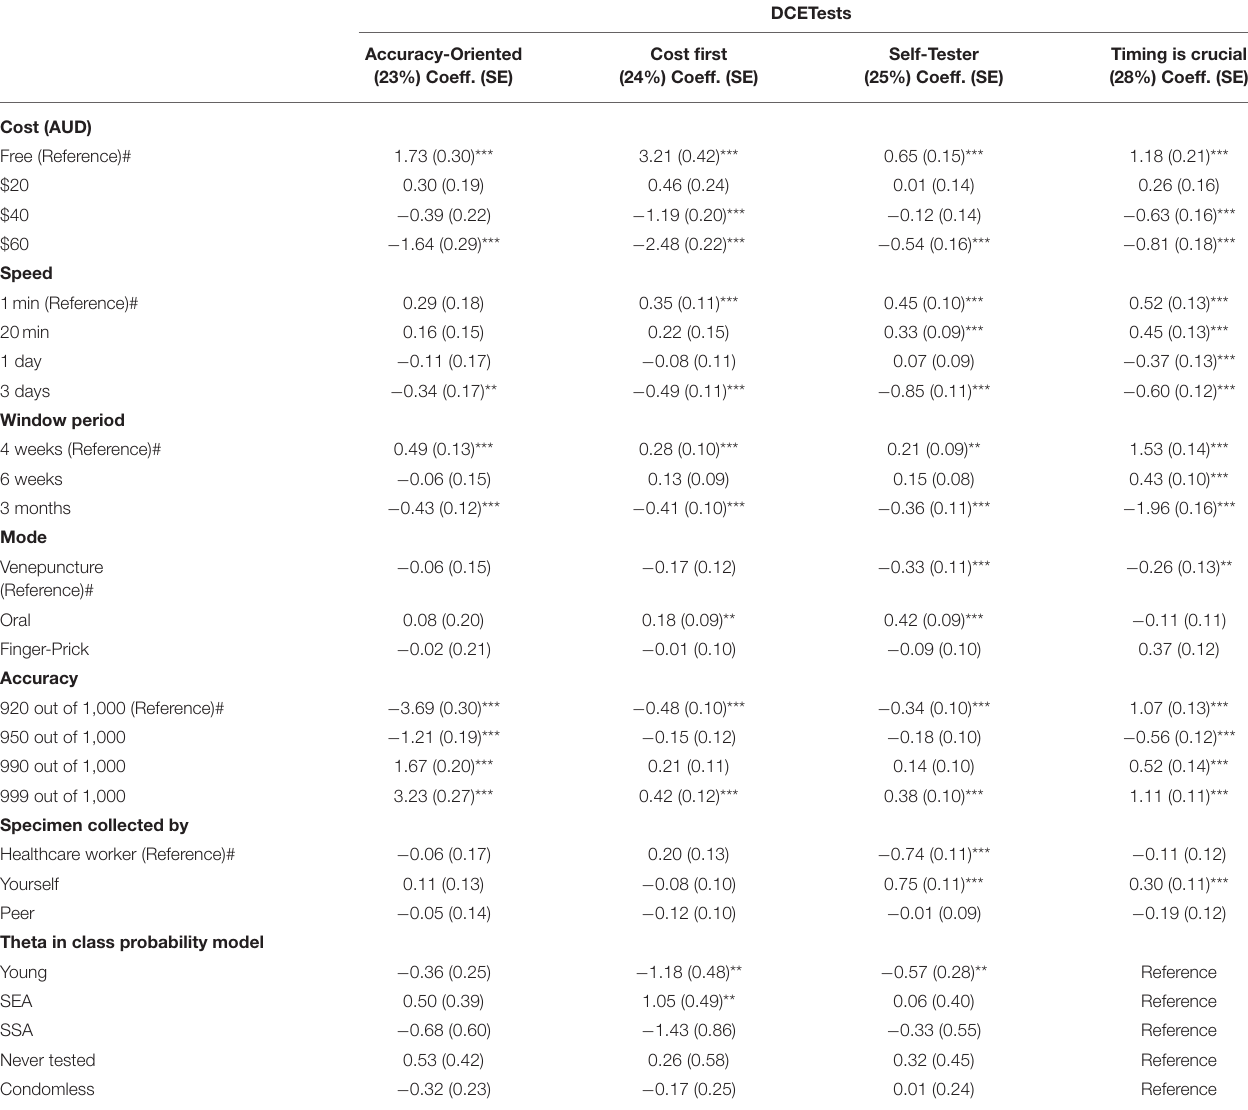
TABLE 4 | Latent class analysis of HIV testing preferences of Australian migrant men who have sex with men born in non-RHCA countries ( N = 298).